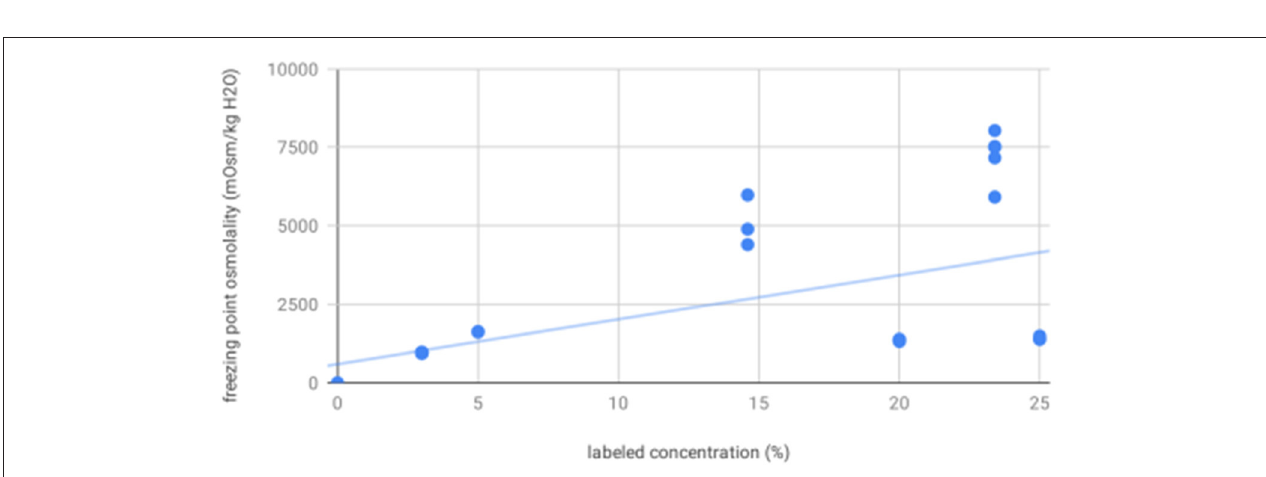
FIGURE 2 | Freezing point osmolality increases with increasing labeled solution concentration—scatter plot showing osmolality as measured by freezing point depression for all solutions increases as a function of increasing labeled solution concentration, as expected.